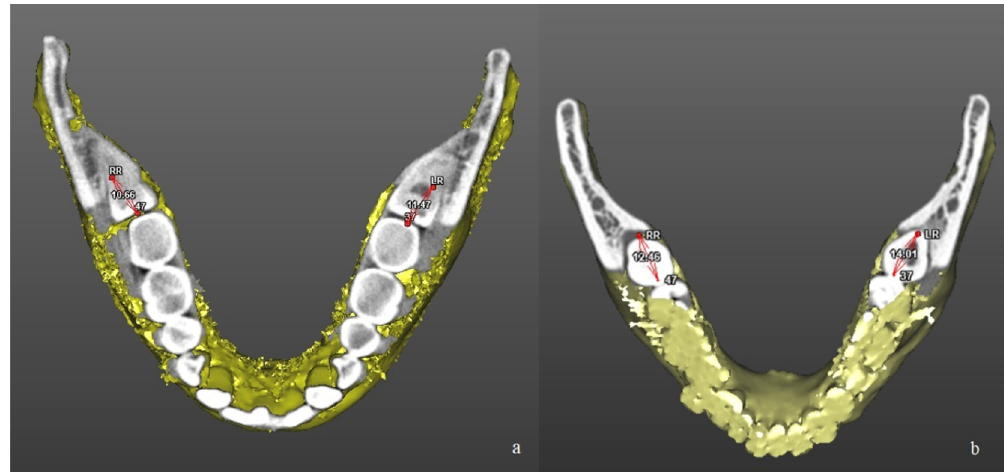
Figure 2. Linear measurement of the retromolar space after three-dimensional reconstruction of CBCT scans in a patient of L-GA group ( a ) and in a patient of H-GA group ( b ). The retromolar space was calculated as the distance between the distal surface of the second molar and the anterior border of mandibular ramus (3.7—Left Ramus; 3.7-LR; 4.7—Right Ramus; 4.7—RR).